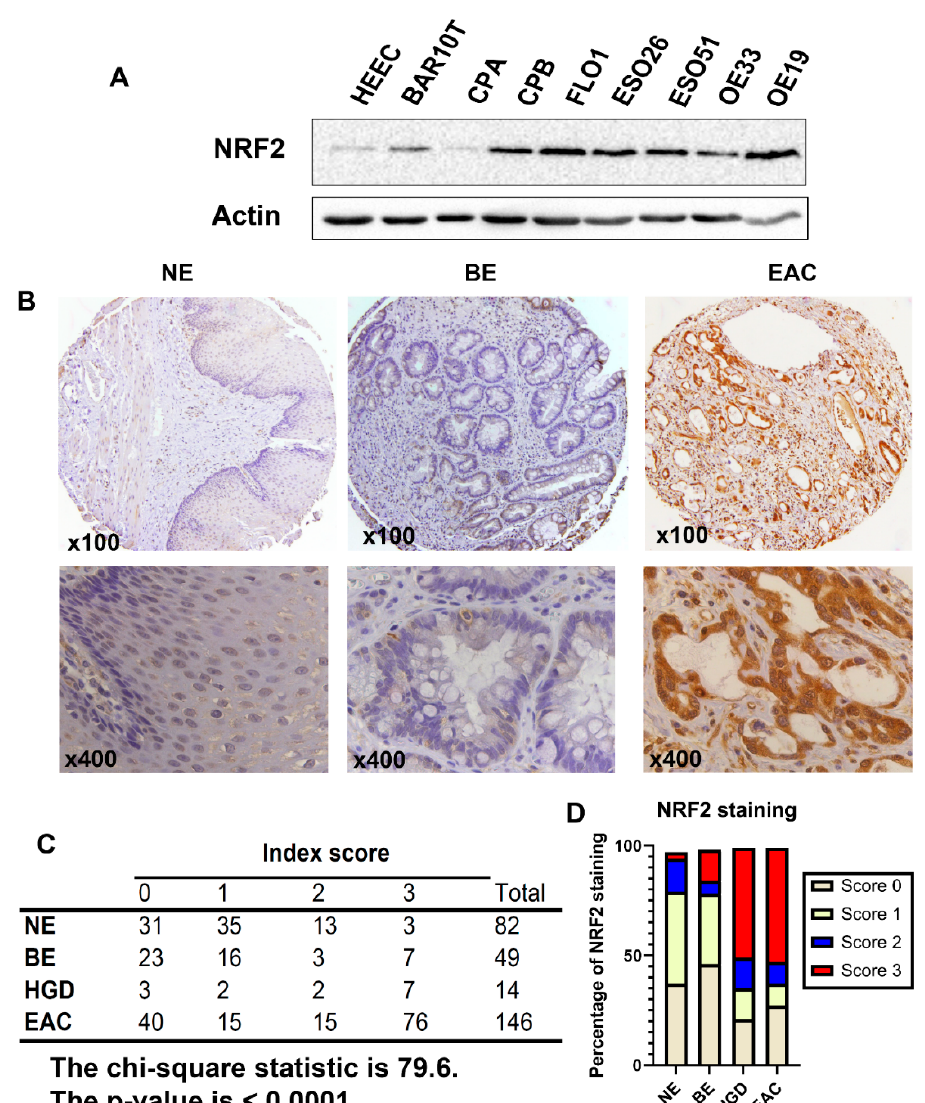
Figure 1. NRF2 protein expression is upregulated in high grade dysplasia and esophageal adeno- carcinoma. ( A ) Western blotting analysis of NRF2 protein expression in cell lines originated from the normal esophageal squamous epithelium (HEEC), Barrett’s esophagus (BAR10T and CPA), dys- plastic Barrett’s (CPB) and esophageal adenocarcinoma (FLO1, ESO26, ESO51, OE33, and OE19). ( B ) Immunohistochemistry analysis of the NRF2 protein expression in primary human tissues of normal esophagus (NE), Barrett’s esophagus (BE), and esophageal adenocarcinoma (EAC), showing overexpression in EAC. Representative images of 100× (upper panels) and 400× (lower panels) are shown. ( C , D ) A summary of NRF2 IHC staining scores in NE, BE, HGD, and EAC from the tissue microarrays, showing high levels of NRF2 in HGD and EAC tissues (the chi-square test, p < 0.0001).